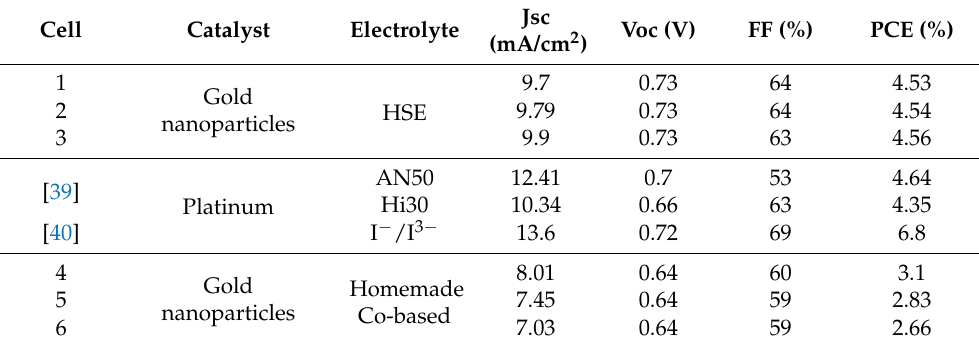
[40] I − /I 3 − Gold Homemade nanoparticles